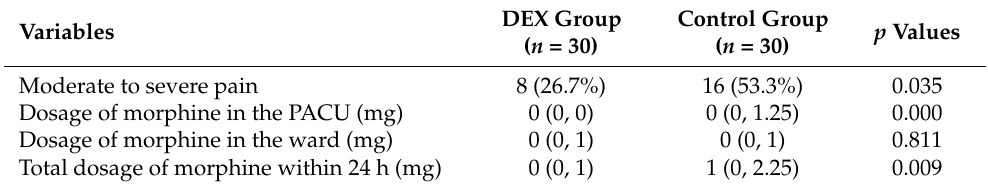
Table 3. Anesthesia and intraoperative data. Variables